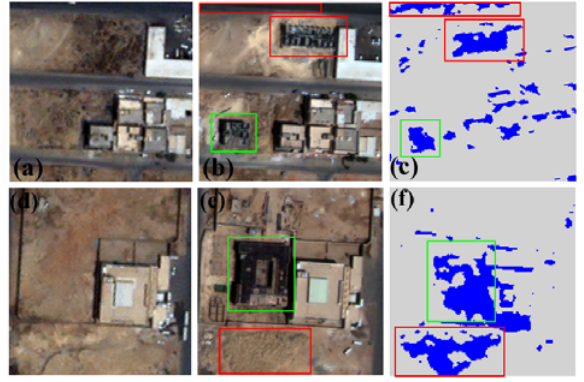
Figure 6. Two samples of the D-DSM – left: IKONOS image (epoch 1), centre: GeoEye image (epoch 2), right: D-DSM. See text for further explanation.